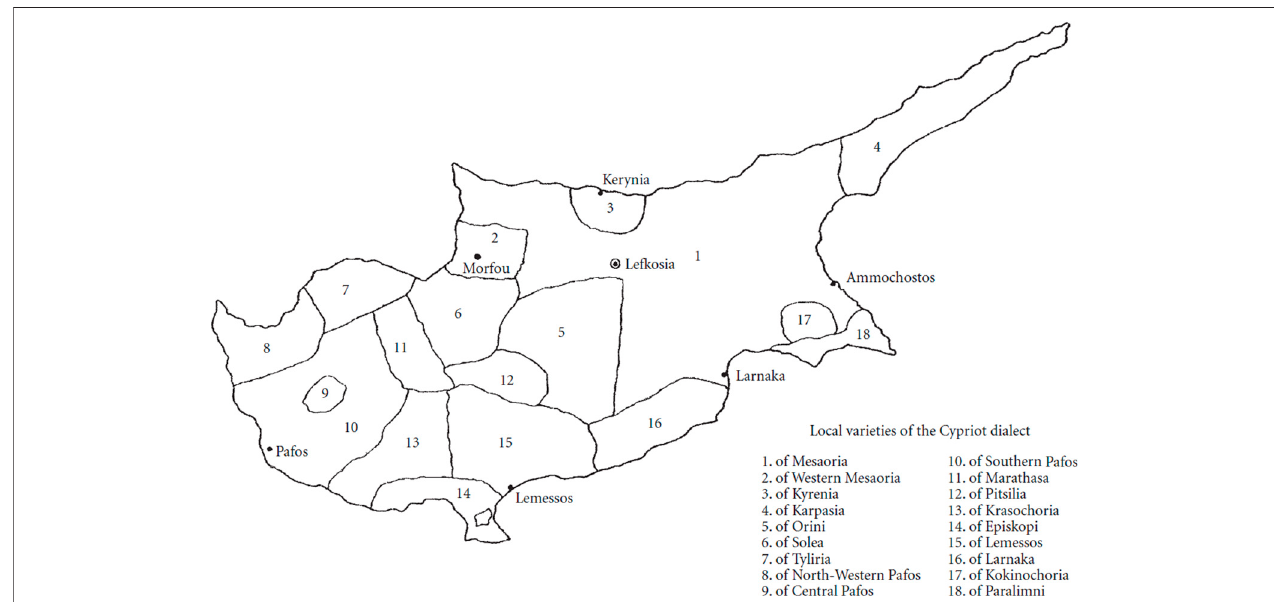
FIGURE 2| 18 geographicaldialect zones in Cyprus. Source: “ Appendix. Local varietiesof the Cypriot dialect (after Contosopoulos 1969, 105) ” cited in Terkoura fi (2005, 372). Reproduced with the permission of John Benjamins Publishing Company.